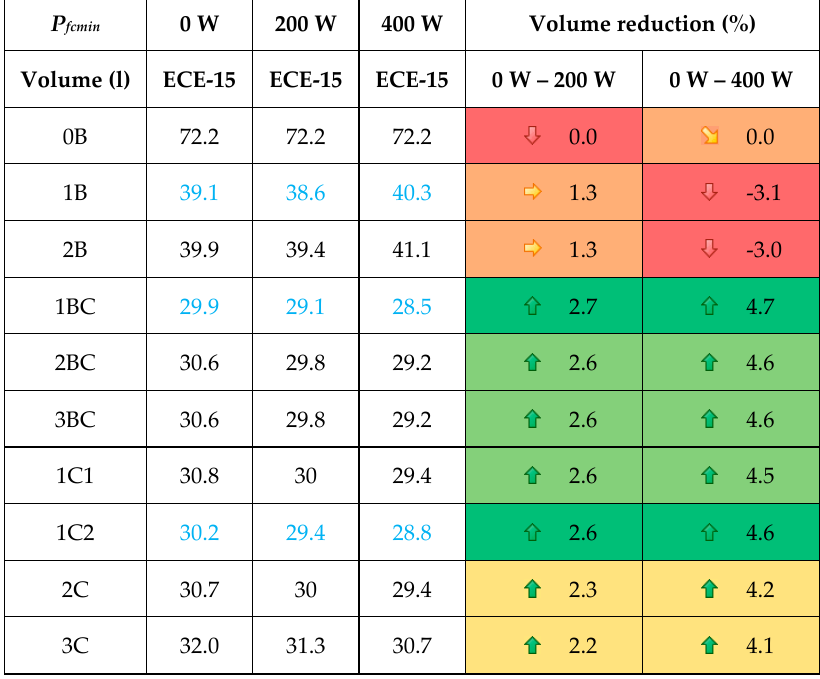
Table 4. Influence of the fuel cell minimum power on PDS volume for the ECE-15 profile.